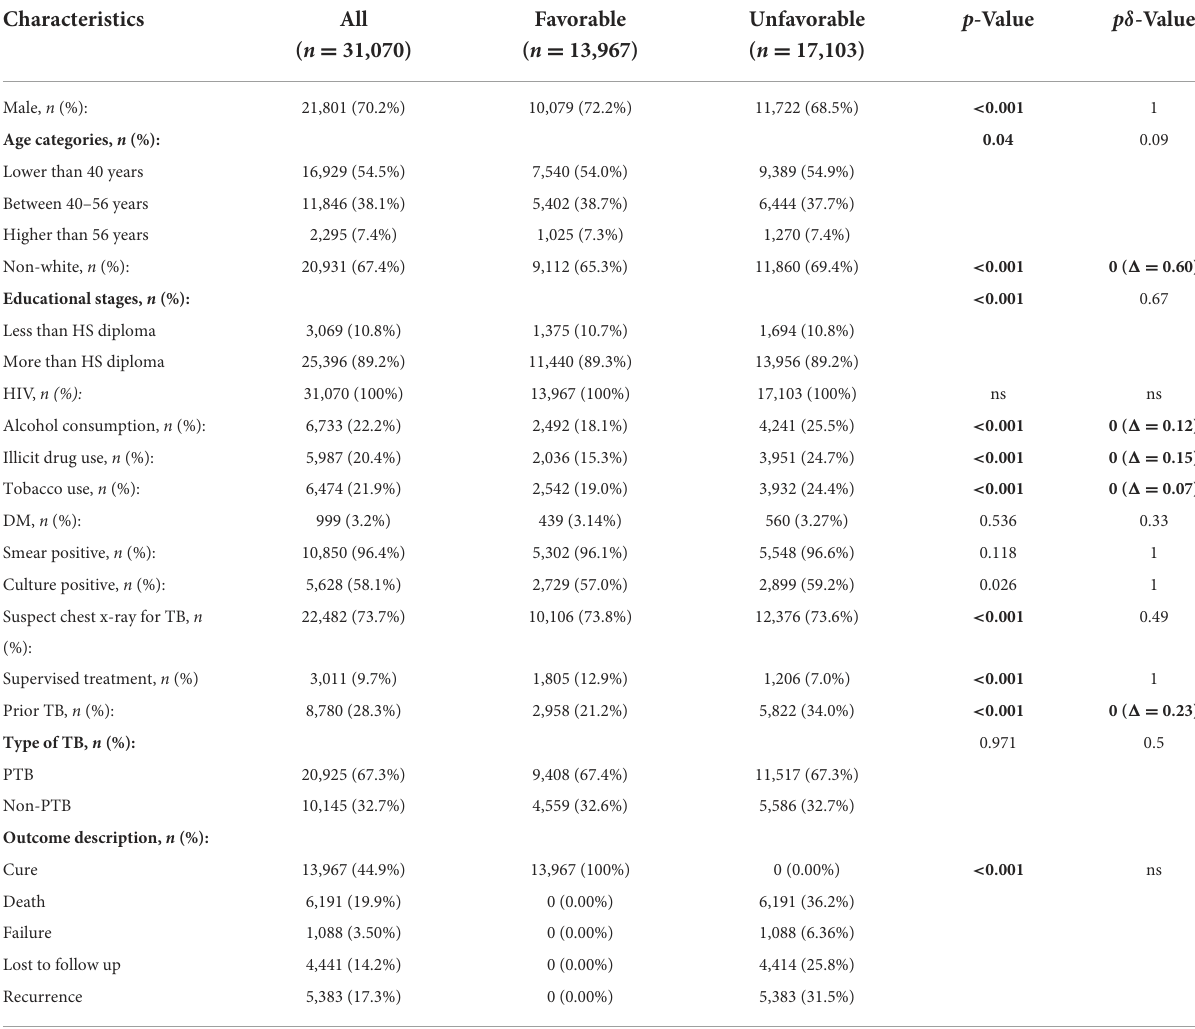
TABLE 2 Characterization of treatment outcomes in the TB-HIV population. Characteristics